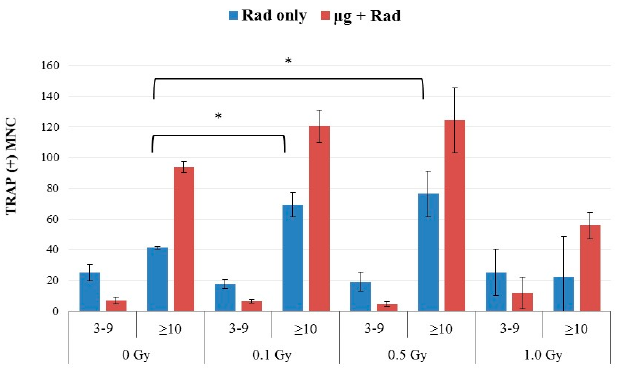
Figure 3. Induction of osteoclast fusion after radiation exposure static (blue bars) and under microgravity (red bars). 0.1 Gy and 0.5 Gy radiation significantly (* p < 0.05 t -test compared to 0 Gy) stimulated osteoclast fusion, but not 1 Gy. The number of multinucleated cells containing ≥ 10 nuclei increased significantly in radiation + simulated microgravity conditions compared with radiation alone (two-way ANOVA: p = 0.0001). Error bars mean SD from three independent experiments.